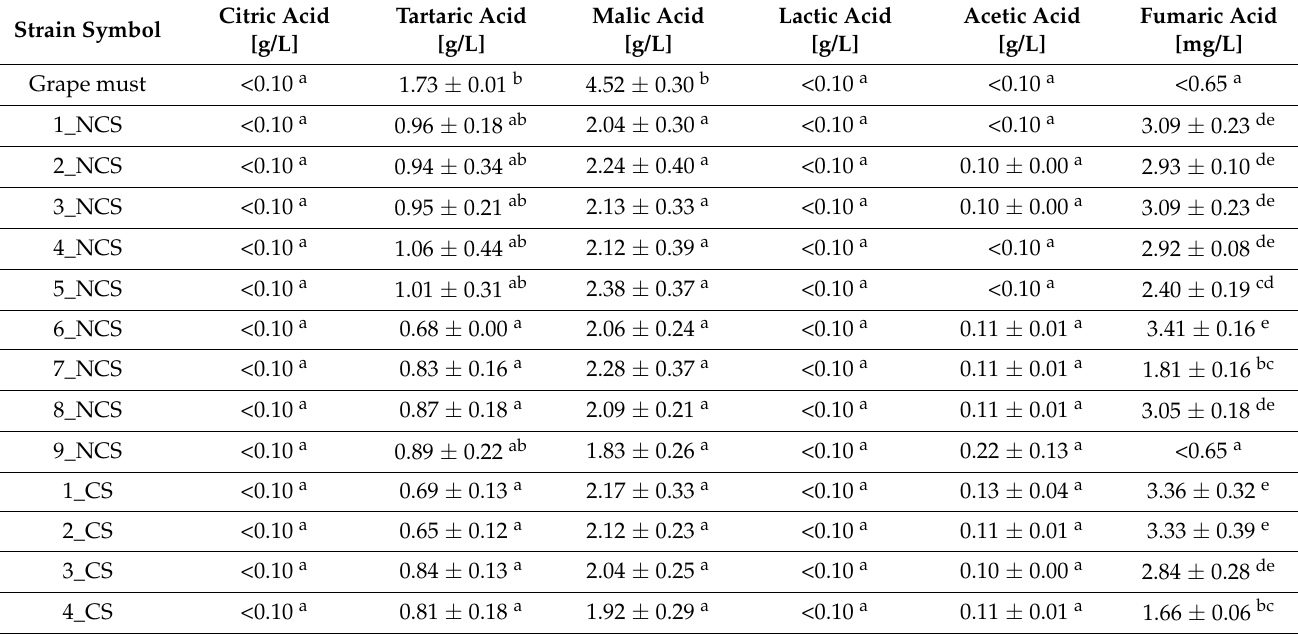
Table 5. Analysis of selected organic acids in white